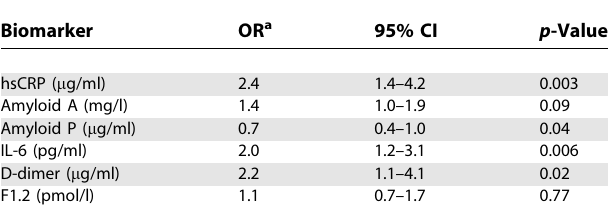
Table 5. Risk of Death Associated with Latest Level of Each